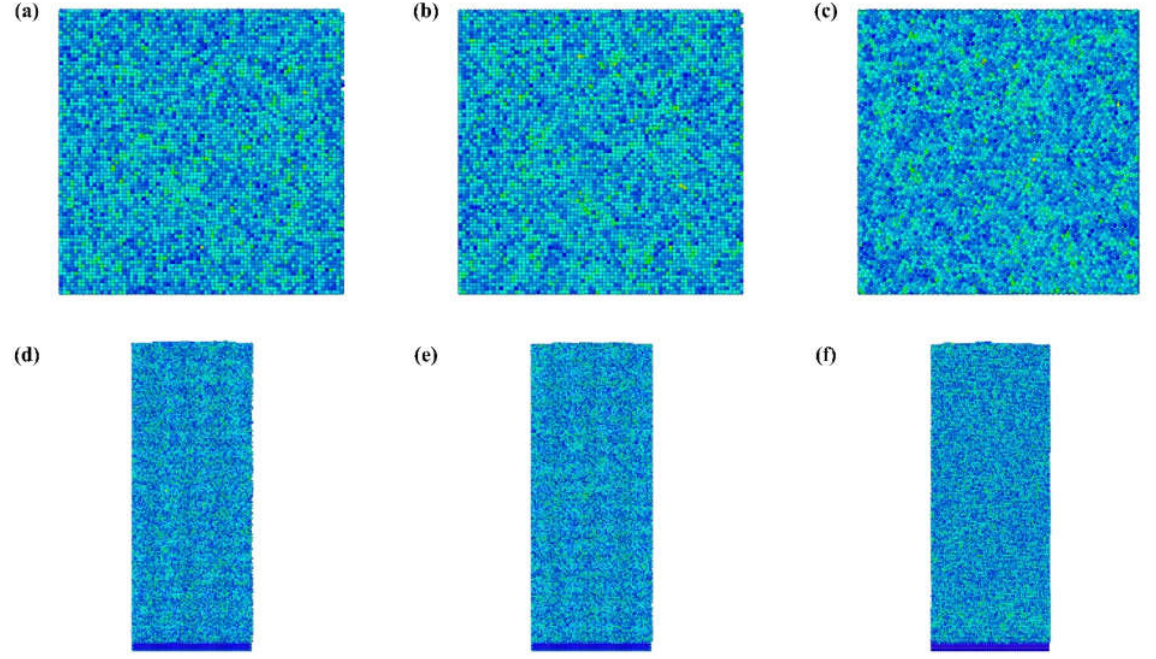
Figure 12. The stress distribution after relaxation, of Al(001) ( a )surface ( d ) cross section, of Al(110) ( b ) surface ( e ) cross section, of Al(111) ( c ) surface ( f ) cross section.